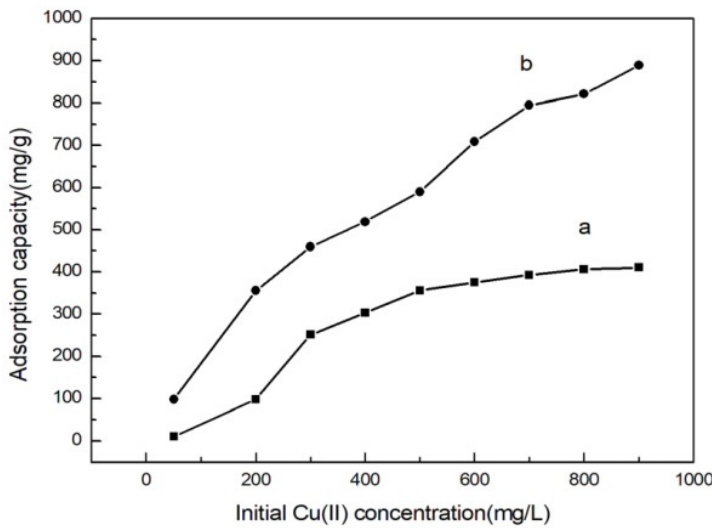
Figure 8. Adsorption behavior of loofah ( a ), and MML ( b ) at different initial concentrations of Cu(II) ions.